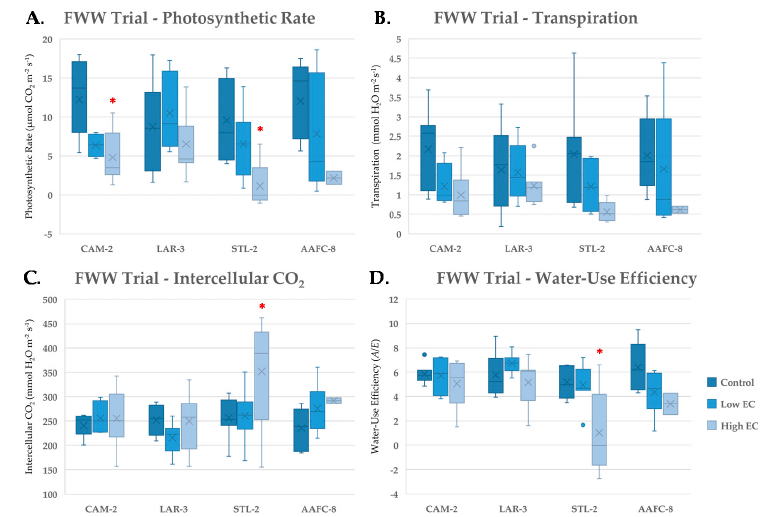
Figure 4. Net photosynthesis ( A ), transpiration ( B ), intercellular CO 2 ( C ) and instanteous water-use efficiency ( D ) (+/ − SEM) of native and hybrid willow genotypes at control, low, and high fracking wastewater treatments following six weeks growth ( n ranged between 4 and 7 for genotypes and treatments). Mean values for hybrid willow at the high treatment are insignificant due to lack of replicates ( n = 2). Asterisks denote significant difference from control treatment ( p < 0.05).